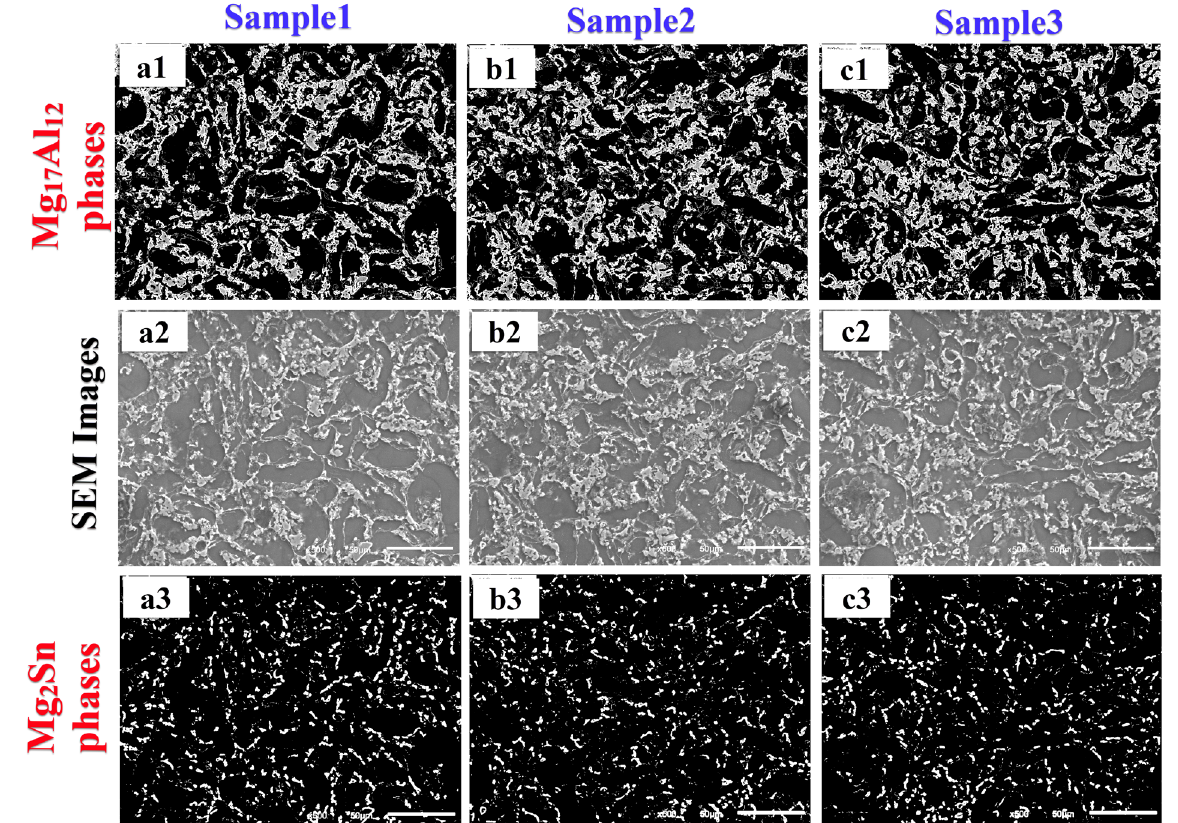
Figure 6. Determined intermetallic phases using CV technology for samples 1, 2, and 3 (horizontal ones refer SEM images and phases; vertical ones refer Samples 1, 2 and 3; 500× magnification, scale bars with 50 µm).